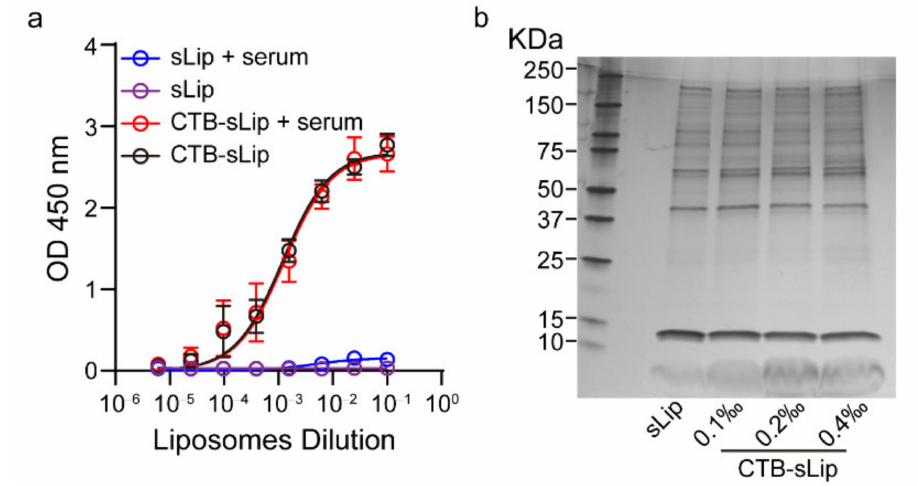
Figure 3. Effects of BALB/c plasma proteins on the bioactivity of CTB-sLip. ( a ) Affinity characteri- zation of CTB-sLip (pre-incubation with BALB/c serum and PBS for 24 h) to GM1 based on ELISA; sLip were set as a control. Data are means ± SDs, n = 3. ( b ) Evaluation of protein corona of CTB-sLip (with 0.1‰, 0.2‰ or 0.4‰ molar ratio CTB modification) by